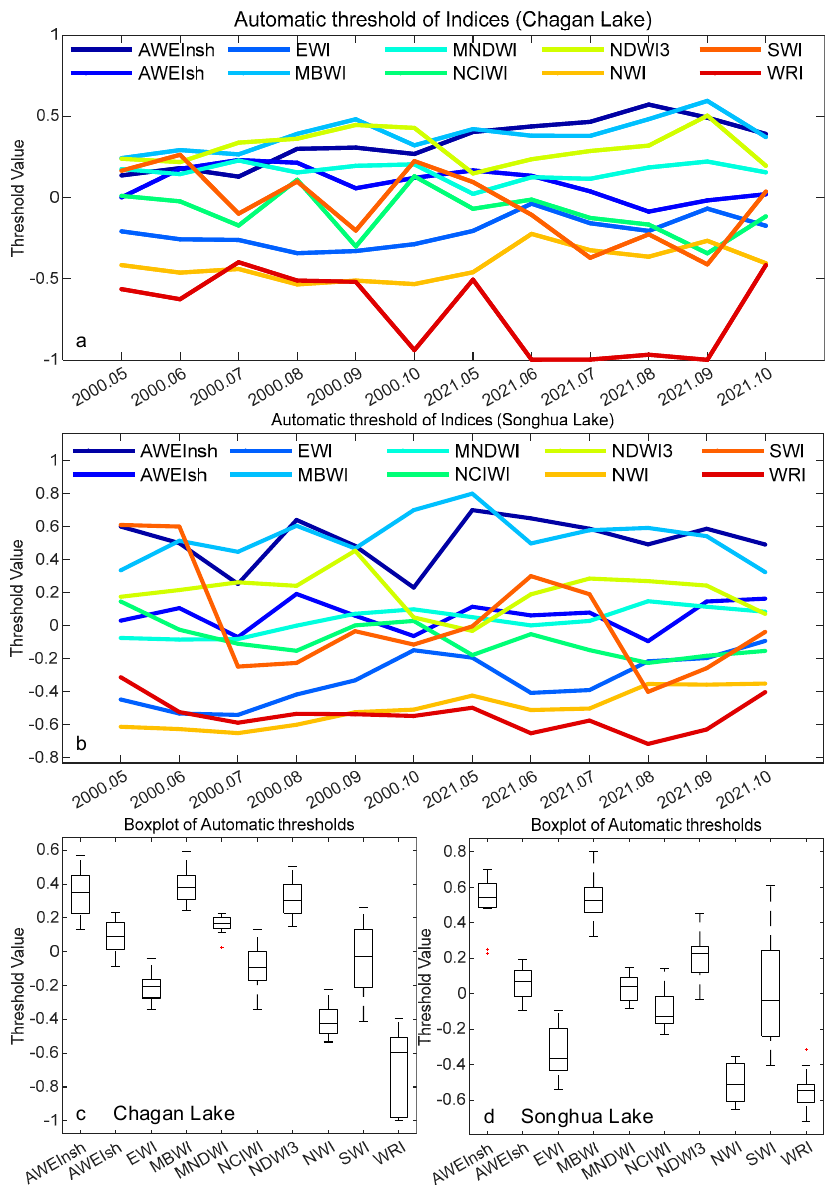
Figure 10. Dynamics of the optimal segmentation thresholds for different indices in different months of the year in the study area of Chagan Lake ( a ) and Songhua Lake ( b ), and the value distribution of these two regions ( c , d ). The red crosses “+” in the value distribution charts ( c , d ) represent the outliers of the samples.